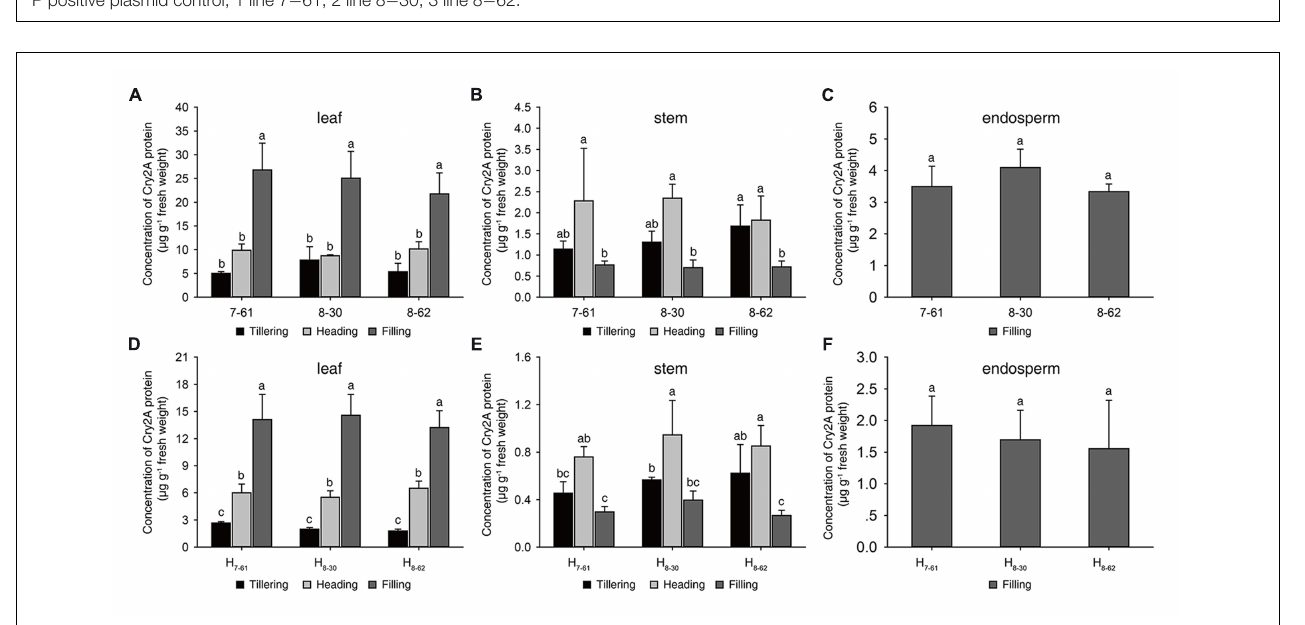
FIGURE 2 | Cry2A protein concentrations in three homozygous lines and their hybrids. (A − C) homozygous lines, (D − F) hybrids. a, b, c: significant difference at P < 0.05. Error bars indicate SD ( n =